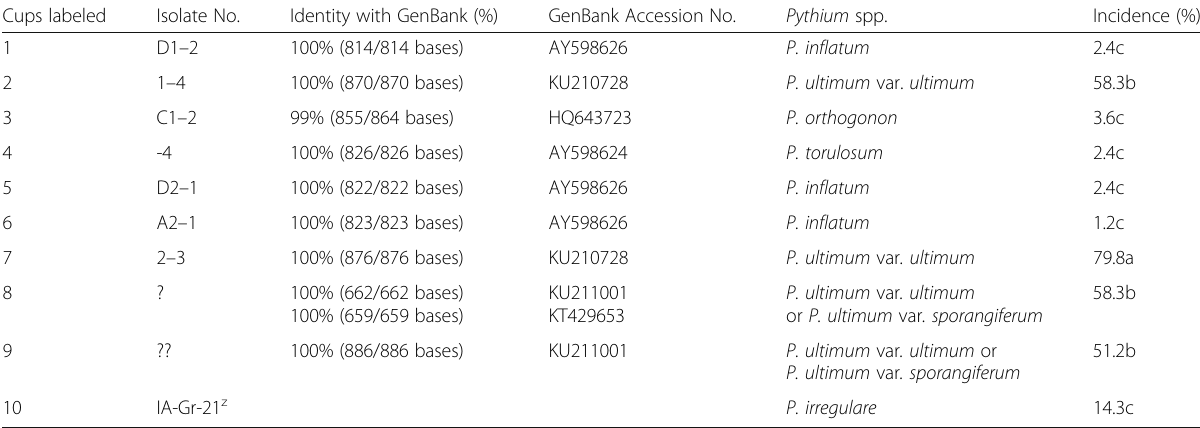
Table 2 Damping-off incidence (%) of Pythium isolates on soybean variety Pioneer 22T61RR in pathogenicity tests conducted in greenhouse x Cups labeled Isolate No. Identity with GenBank (%) GenBank Accession No. Pythium spp.